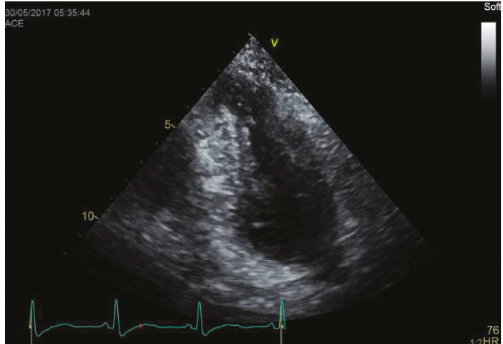
Figure 3: Apical 2 chamber view captured at end systole showing basal and apical akinesis with preserved contractility of the mid ventricular segments.